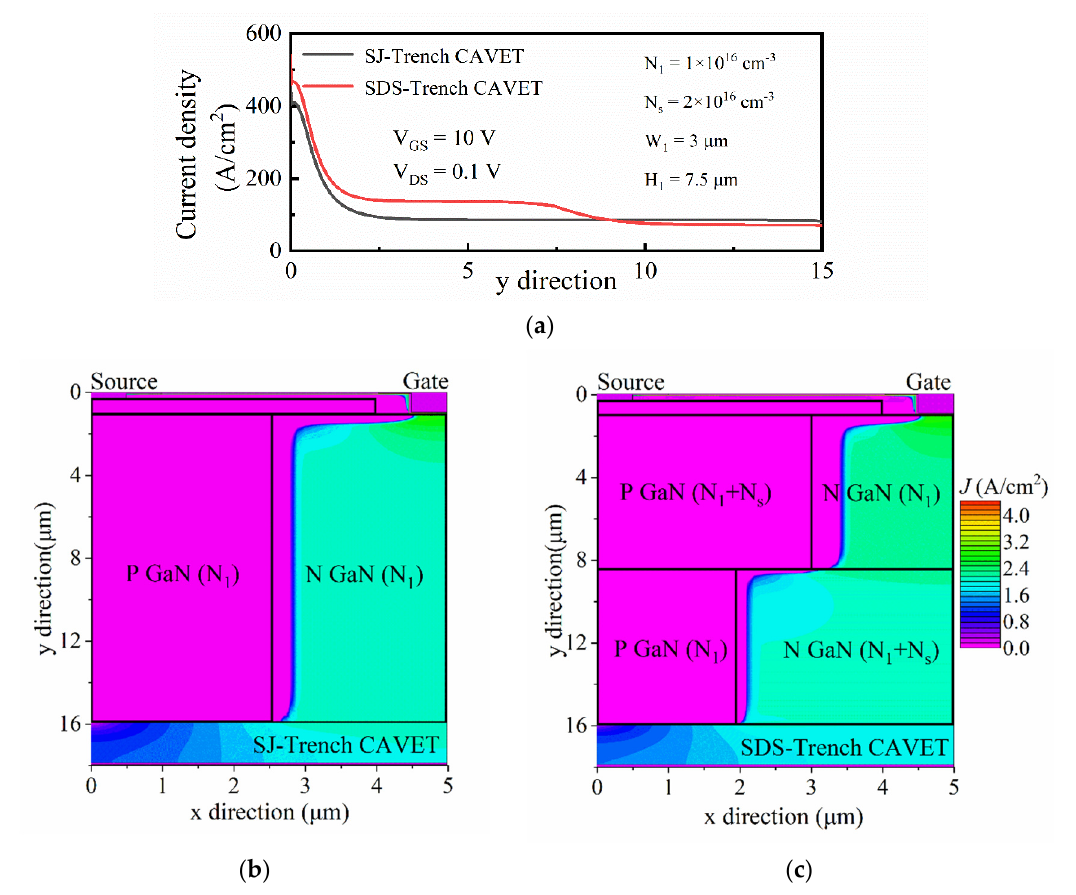
Figure 4. ( a ) On-state current-density curve of two devices along line L1L2 and ( b , c ) correspond- ing total two-dimensional distribution for SJ-Trench CAVET and SDS-Trench CAVET under the conditions of V GS = 10 V and V DS = 0.1 V (in log scale).